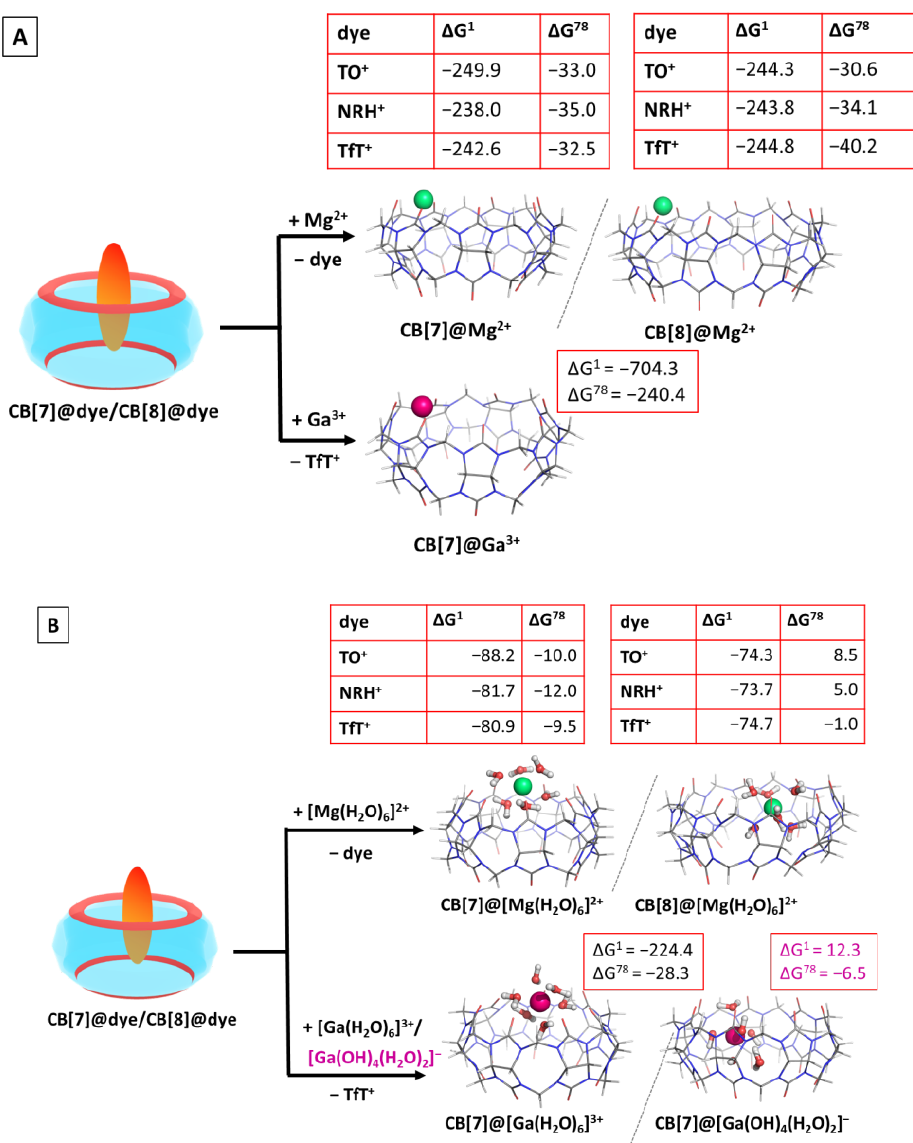
Figure 4. M062X/6 − 31G(d,p) optimized structures of the CB[7/8]@metal complexes in the gas phase and the corresponding ∆ G ε values in kcal mol − 1 for their formation in the gas phase ( ε = 1), and water ( ε = 78) at the M062X/6 − 31+G(d,p)//M062X /6 − 31G(d,p) level of theory by substituting the dye from the host cavity. The results are obtained by considering the bare ( A ) and hydrated ( B ) metal cations. The hydration shell around gallium(III) is modelled as [Ga(H 2 O) 6 ] 3+ /[Ga(OH) 4 (H 2 O) 2 ] − in correspondence with its pK a values.